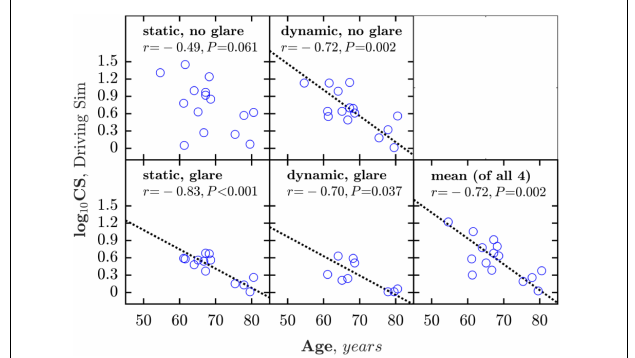
FIGURE 6 | Correlations between age and CS measured under the four simulator conditions (glare/no-glare vs. static/dynamic). The bottom right panel shows mean CS averaged across all four measures. Dashed line shows geometric mean regression slope (shown only where association was statistically